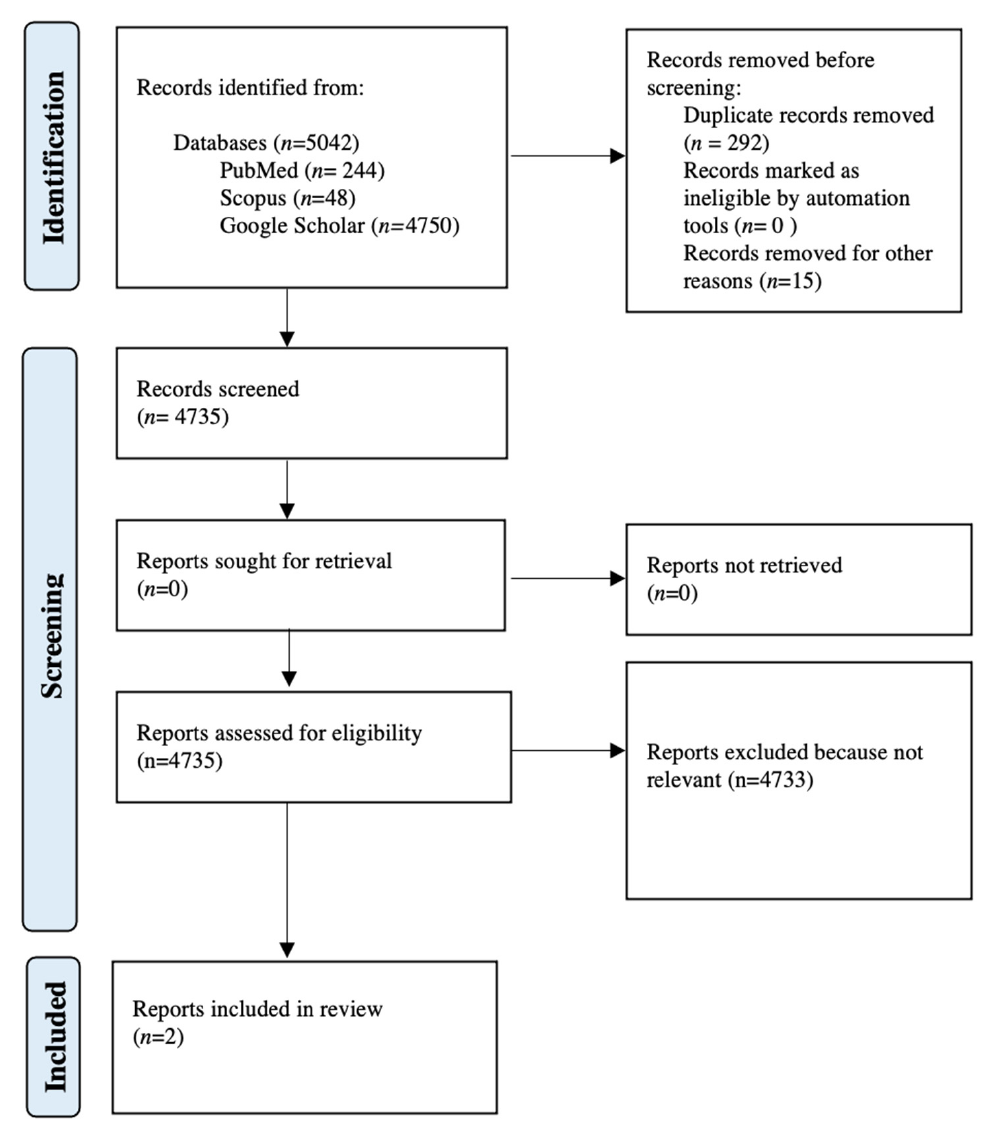
Figure 2. PRISMA flow diagram.